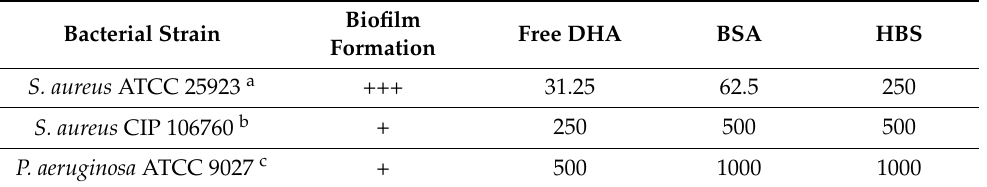
Table 2. Minimum inhibitory concentration (MIC) values ( µ g/mL) of DHA against Gram-positive ( S. aureus ATCC 25923 and S. aureus CIP 106760) and Gram-negative ( P. aeruginosa ATCC 9027) bacteria. Results showed as mean ± SD, p < 0.05. Bacterial